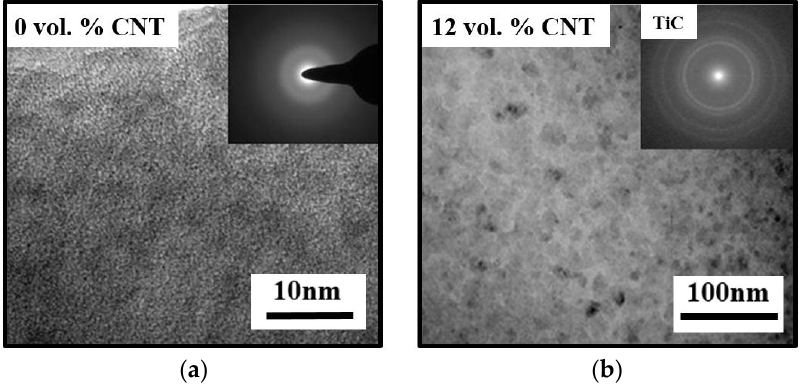
Figure 3. Transmission electron microscopy (TEM) images of mechanically alloyed Ti 50 Cu 28 Ni 15 Sn 7 and composite powders after 8 h milling: ( a ) 0% CNT; ( b ) 12% CNT.